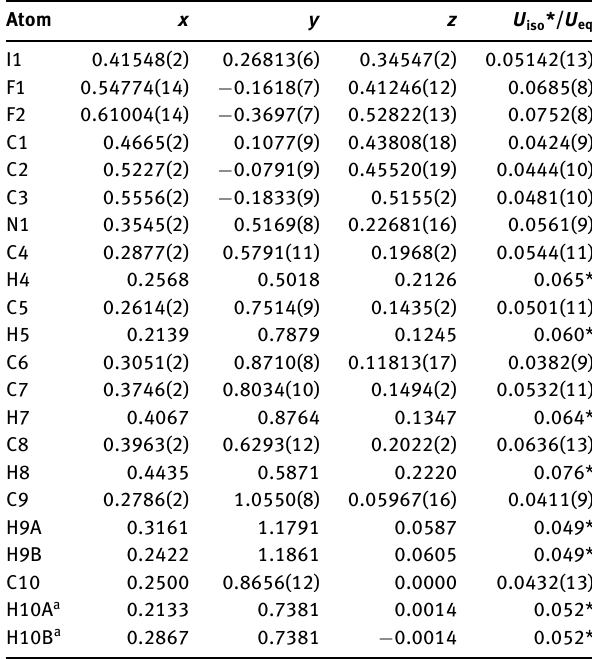
Table 2: Fractional atomic coordinates and isotropic or equivalent isotropic displacement parameters (Å 2